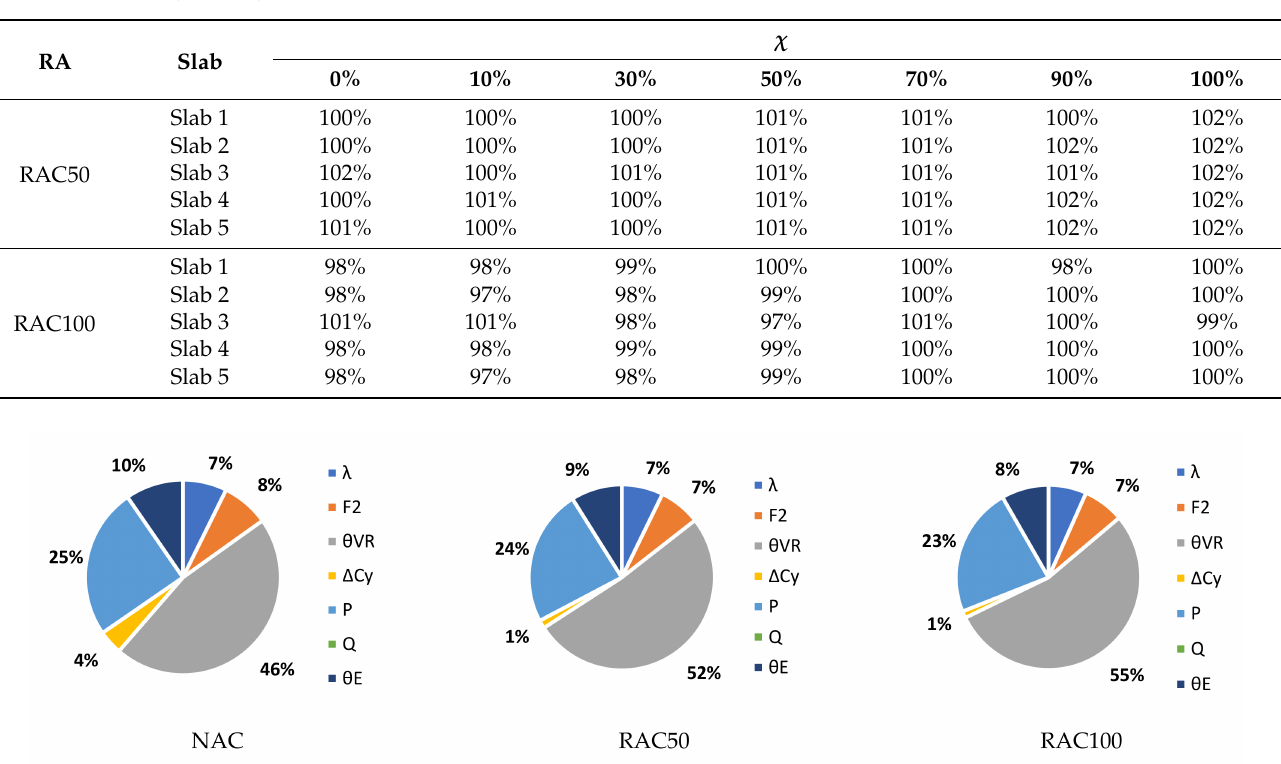
Table 9. Ratio β RAC/ β NAC of slabs. EN1992 [31]. γ NAC = 1.45; γ RAC 50 = 1.55; γ RAC 100 = 1.60 (no calibration needed).